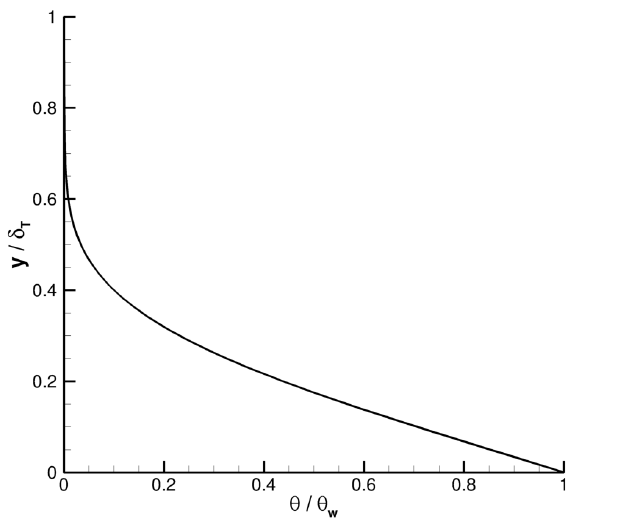
Figure 4. Non-dimensional temperature profiles for N = 4 at all the points of the grid. Test case 1, N x = 256.